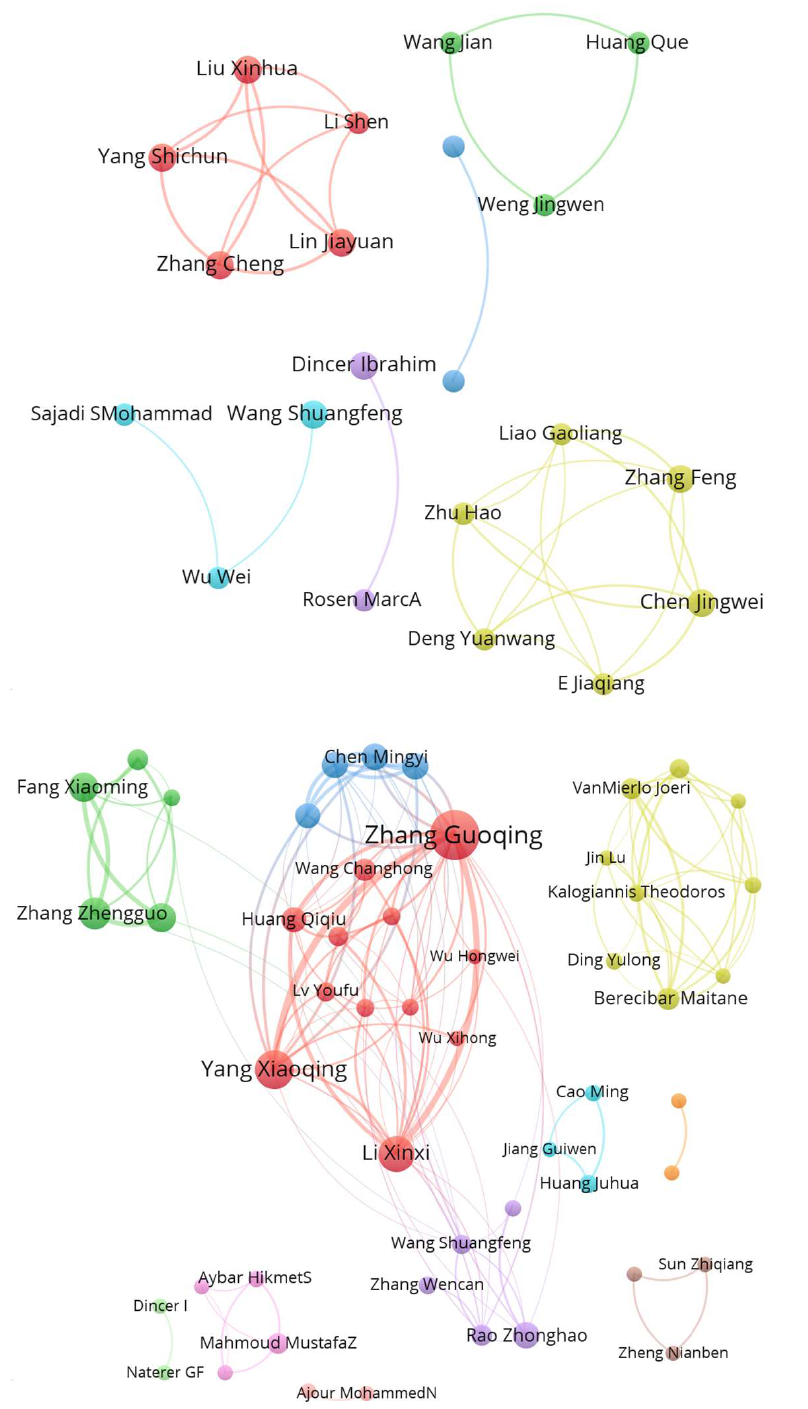
Figure 4. Collaborative network of distinct authors. ( a ) Author cooperative network in reviews; ( b ) author cooperative network in research